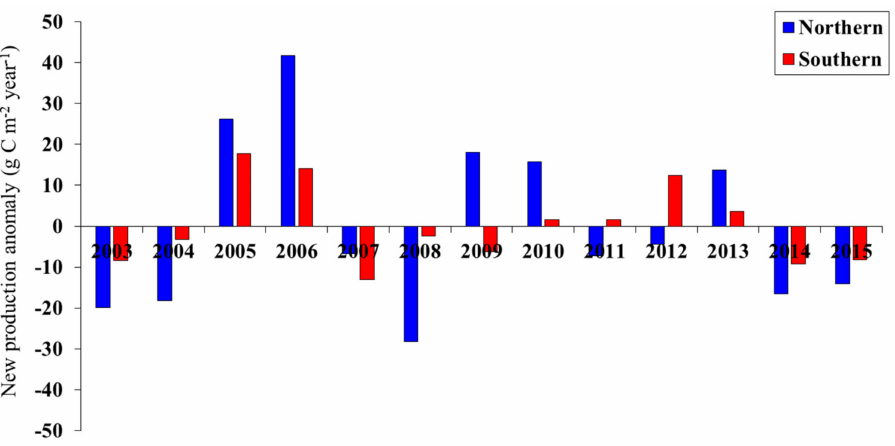
Figure 8. Anomalies of the annual new productions in the northern and southern East/Japan Sea (EJS) during the study period. The blue color bars and red color bars represent the northern and southern East/Japan Sea (EJS), respectively.